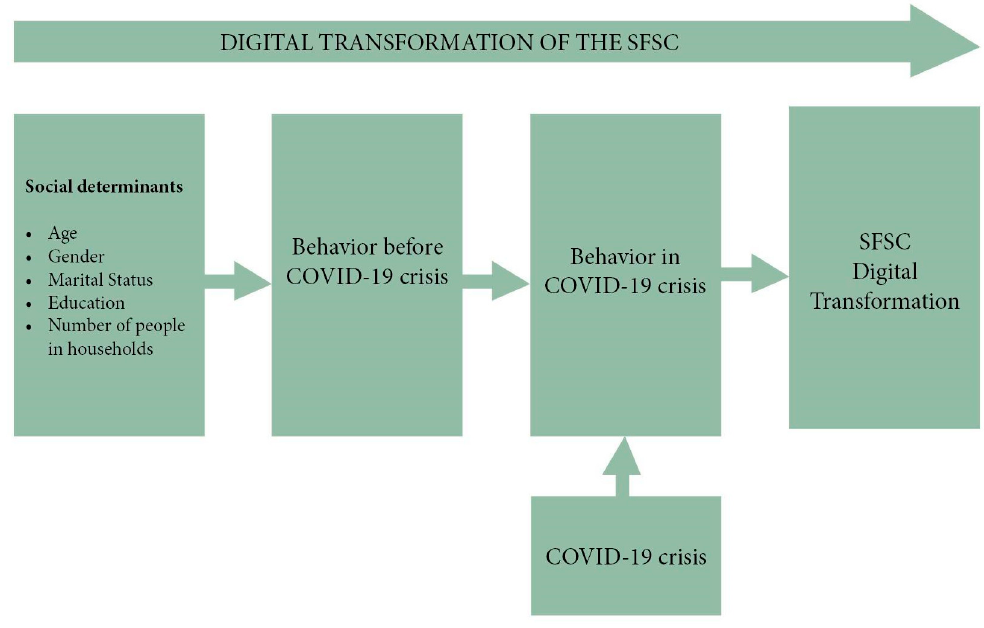
Figure 2. The narrative-argumentative sketch of the proposed research.